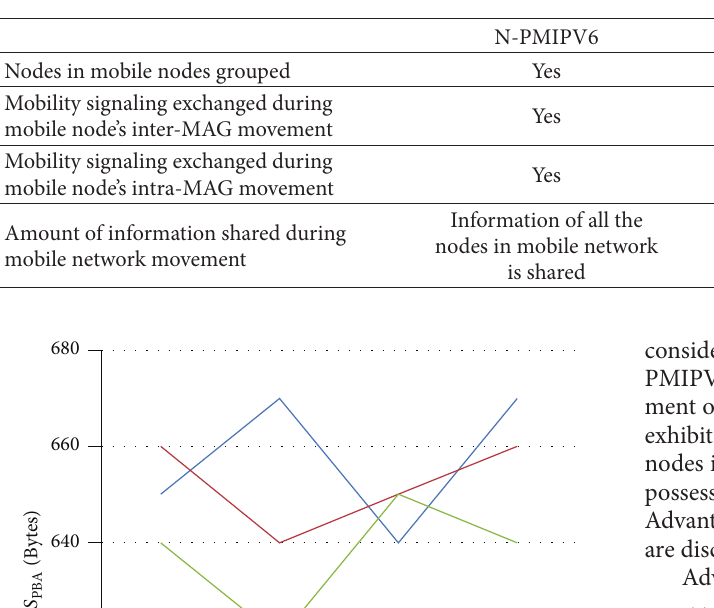
Table 3: Comparative study.